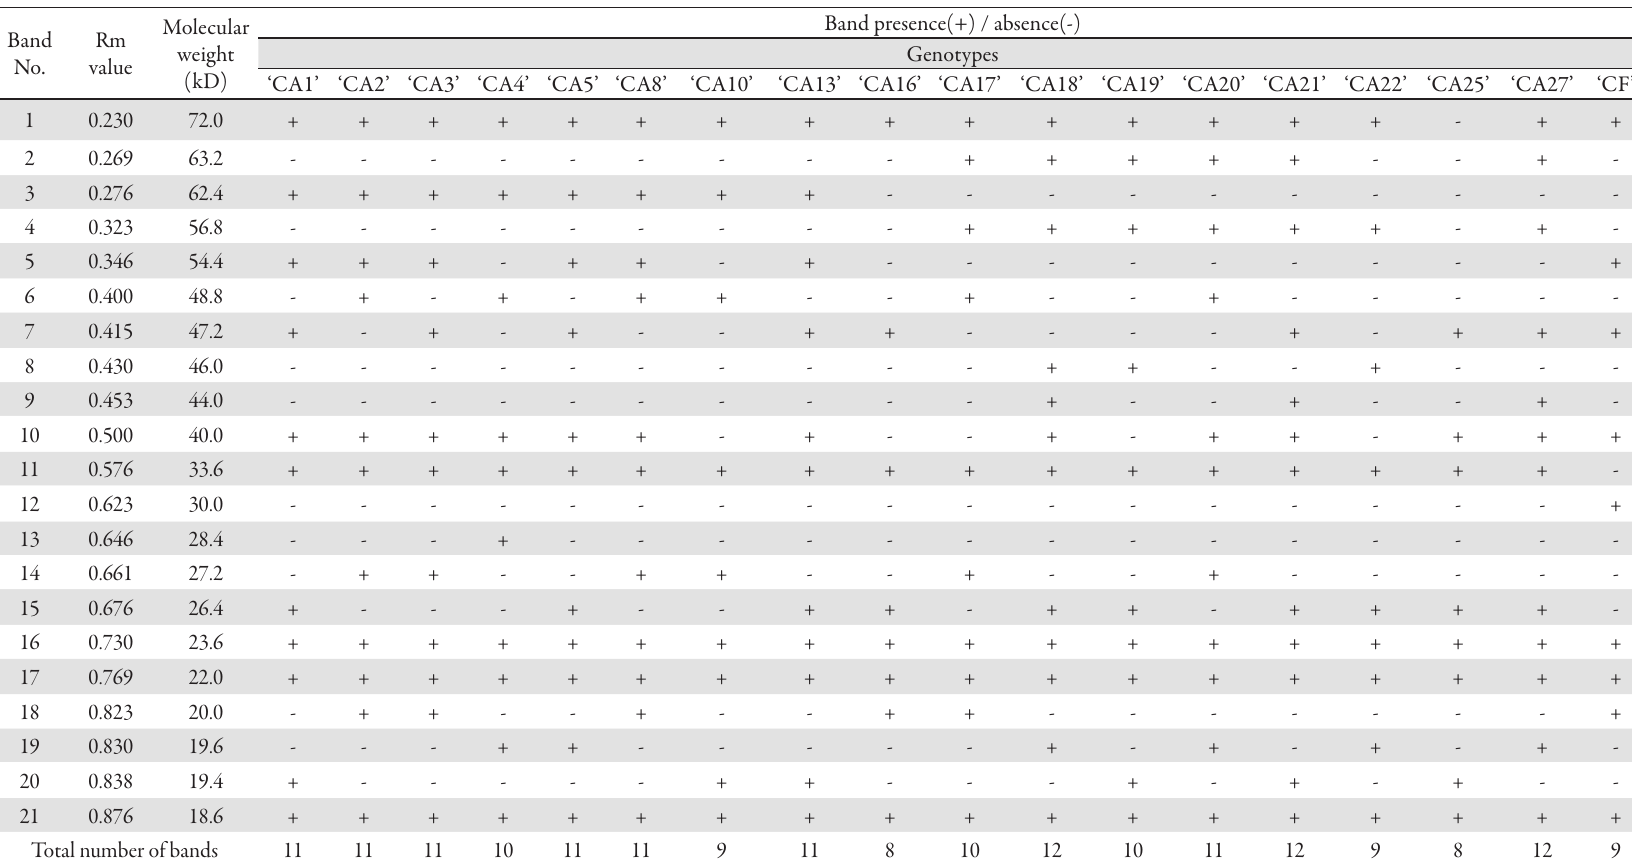
Tab.1. Rm values, molecular weights and band presence or absence in eighteen genotypes of chili pepper ( Capsicum